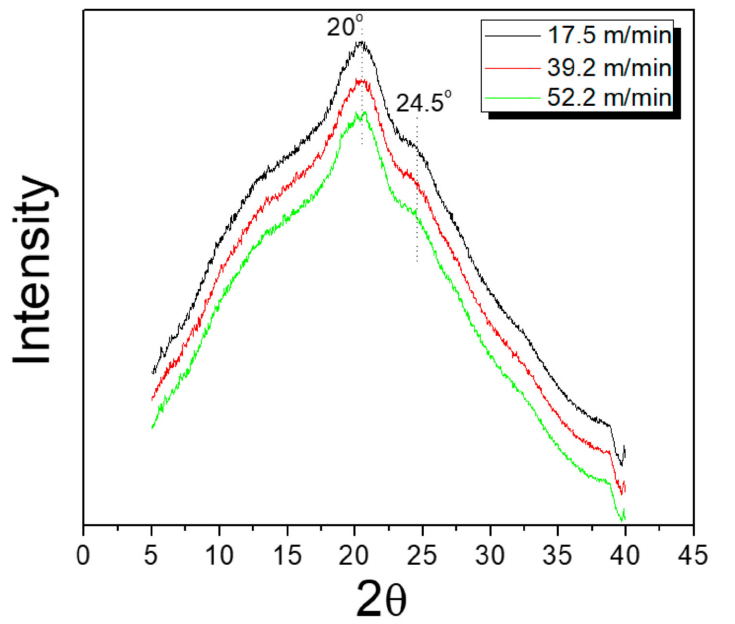
Figure 2. X-ray diffractograms of silk webs prepared at various reeling velocities.